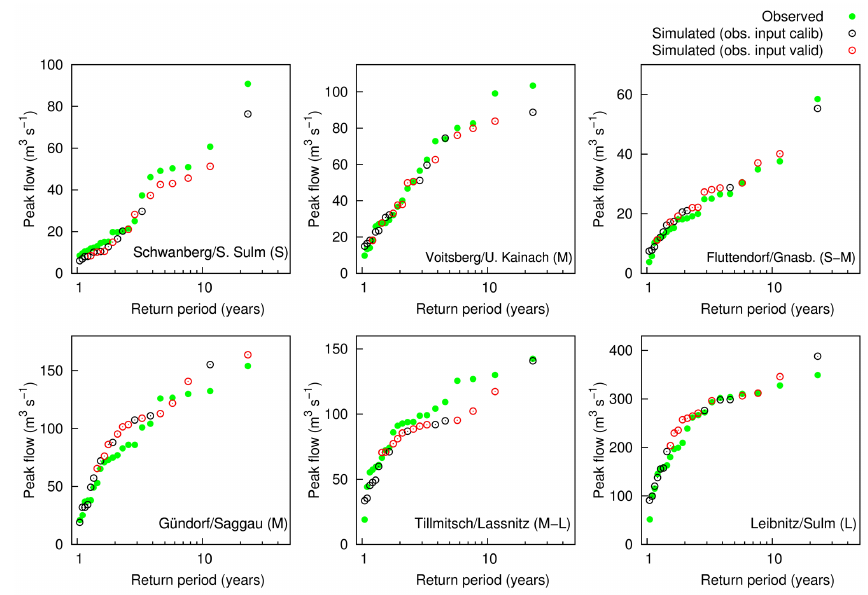
Figure 6. Simulated and observed maximum annual flood peaks vs. empirical return periods (Eq. 1, flood frequency plots) of the selected gauges in the period 1989–2010. The peaks in the validation period are marked with red